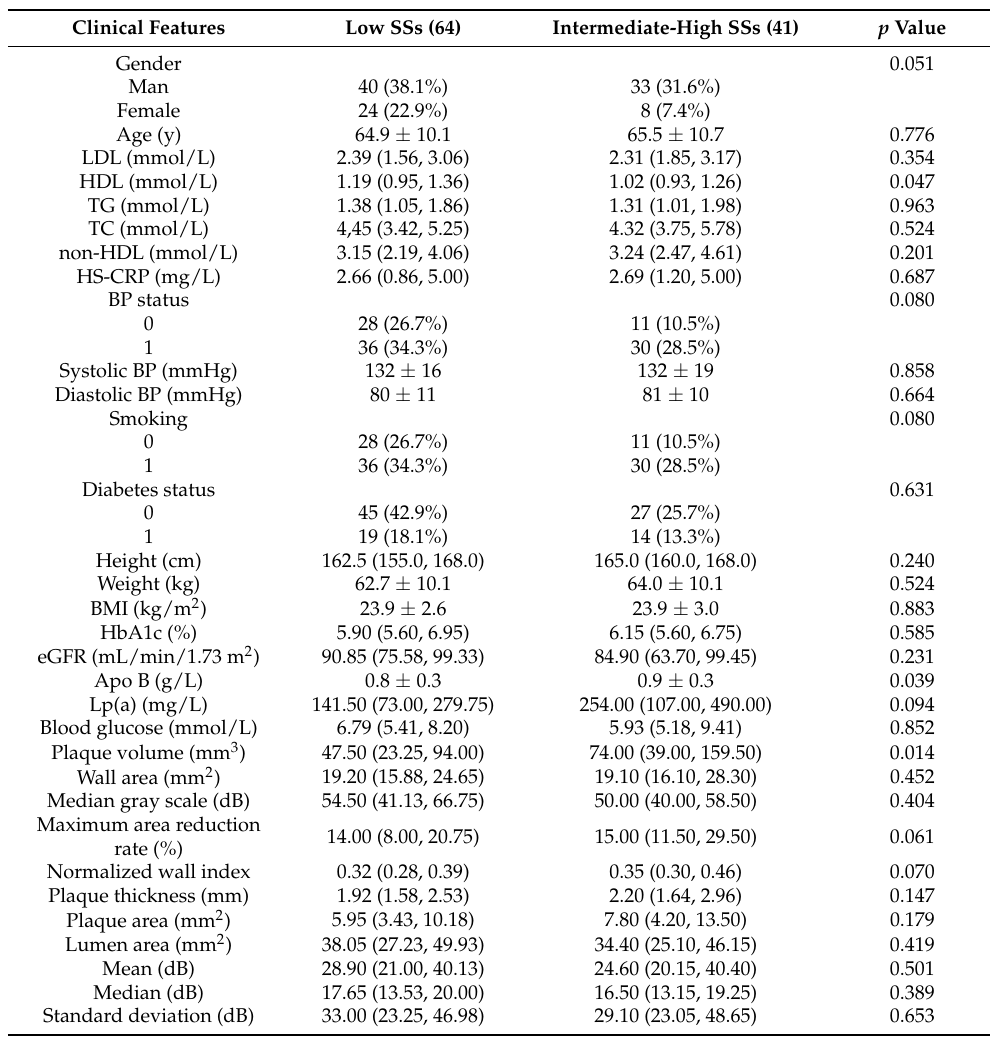
Table 1. Clinical characteristics of all